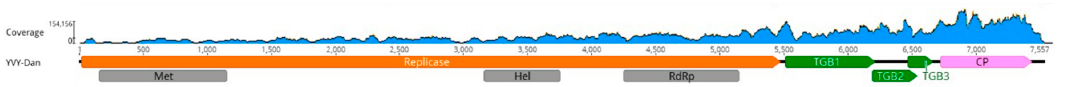
Figure 1. Schematic representation of the genome organization of yam virus Y isolate Danicha (YVY-Dan). Five predicted open reading frames (ORFs) are shown: ORF1 = replicase (orange); ORF2, ORF3, and ORF4 = triple gene blocks (TGB) 1, 2, and 3, respectively (green); ORF 5 = coat protein (CP) (pink). Conserved motifs for viral methyltransferase (Met, pfam 01660), viral helicase_1 (Hel, pfam 01443), RNA-dependent RNA polymerase_2 (RdRp, pfam 00978) are shown in grey. A graphic coverage plot spanning the entire sequence is shown above the YVY-Dan genome.